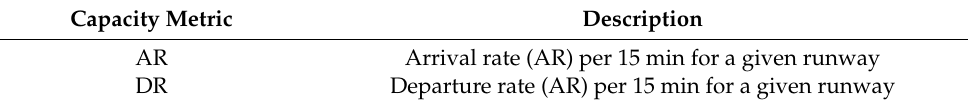
Table 7. Capacity